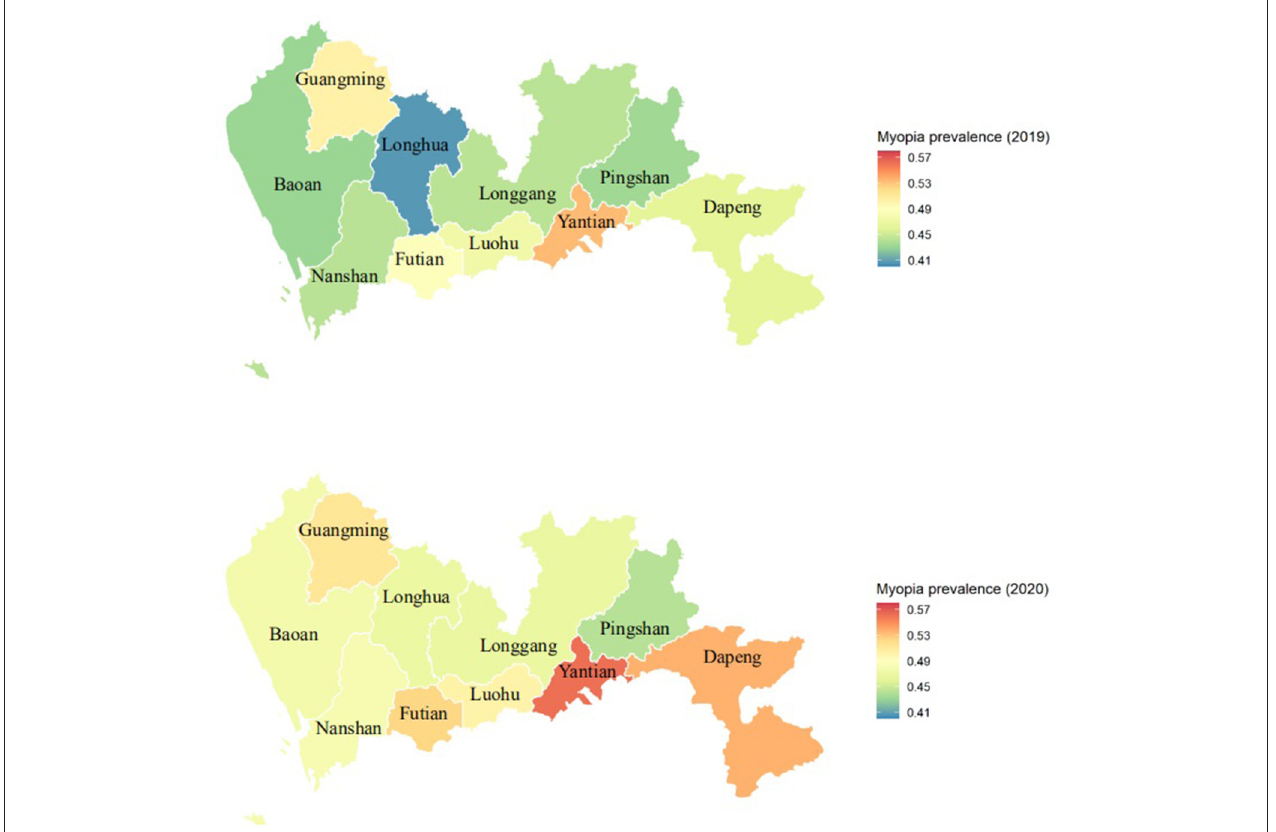
FIGURE 1 | The spatial distribution map of the prevalence of myopia in elementary and middle school students in Shenzhen, China.